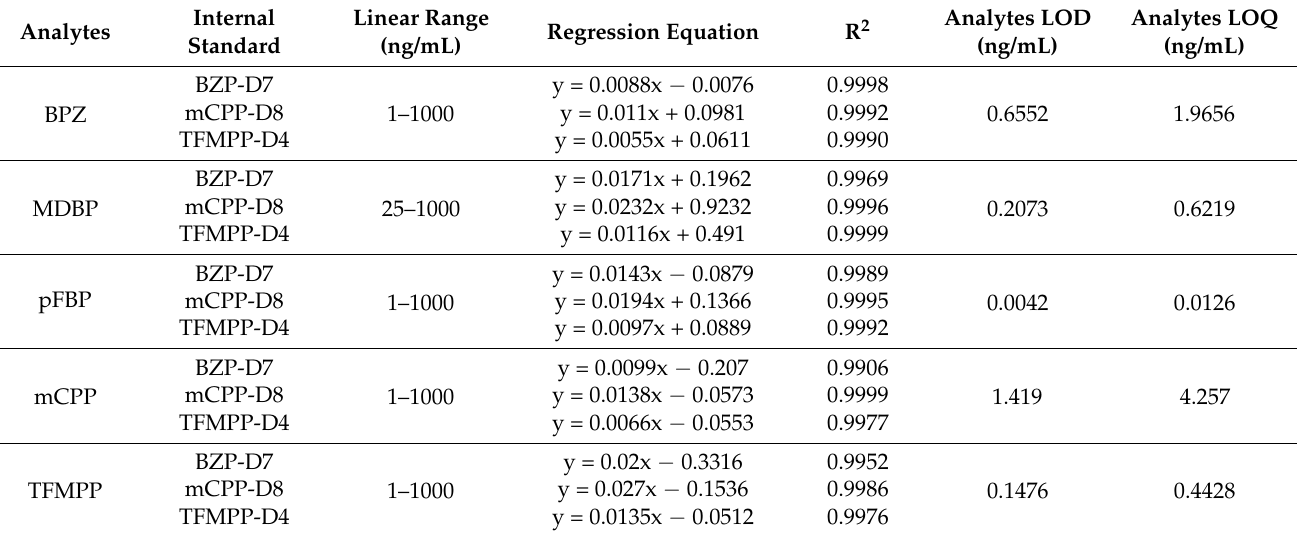
Table 2. Validation parameters (linear range, regression equation, determination coefficient (R 2 ) and analytical limits).